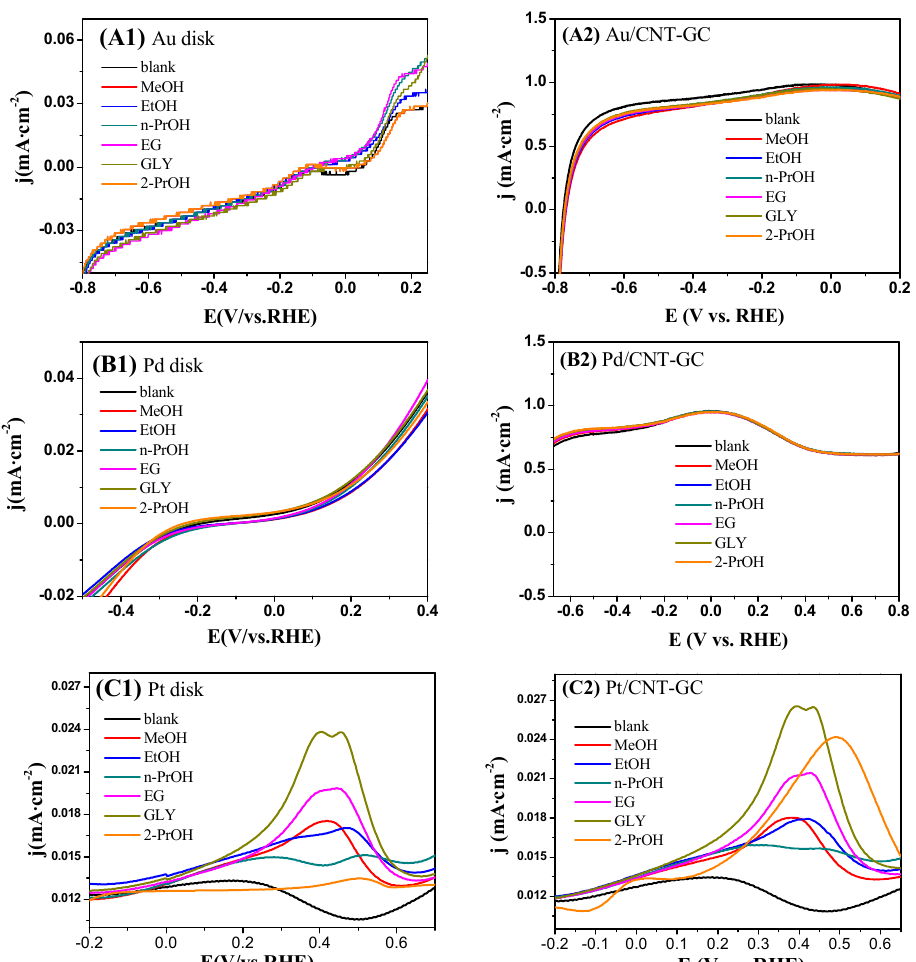
Figure 7. Voltammetry curves of alcohol electro-oxidation over different electrodes in 0.05 M K 2 SO 4 solution.